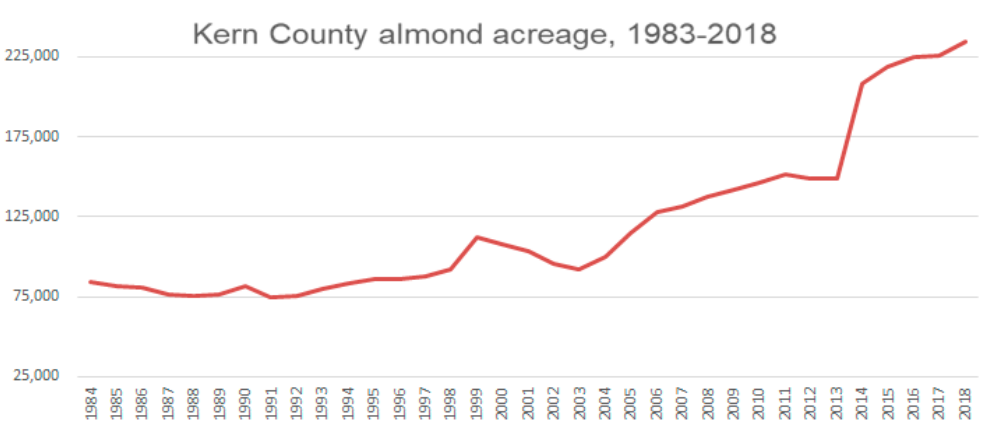
Figure 1. Total almond acreage by year for Kern County [25,27,28].